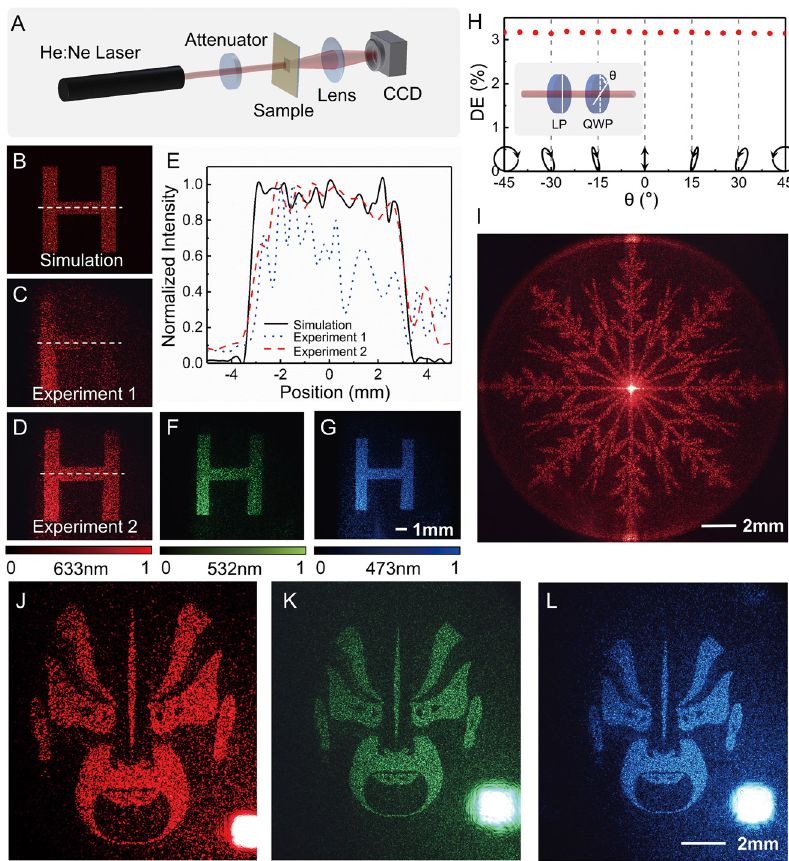
Figure 5: Comparison of holographic imaging quality and analysis of optical characteristics. (A) Scheme of homemade optical system for holographic image reconstruction. (B) Simulated reconstructed image of the calculated binary hologram. (C), (D) Optical images reconstructed from the fabricated holograms shown in Figure 4 C, D, respectively. A 633-nm laser was employed inmeasurement.Thedefinitionofthe “ H ” in (D) is superior to that in (C). (E) Normalized intensity profiles along the white dashed lines in (B) – (D). The black line (simulation) corresponds to the simulation result in (B). The blue dotted line (experiment 1) and the red dashed line (experiment 2) are plotted from (C) and (D), respectively. (F), (G) Optical images reconstructed from the hologram in Figure 4 D under irradiation by laserswith wavelengths of 532 and473 nm, respectively. (H) Measured differential efficiency of the hologram under different polarization states of the 633-nm laser by tuning the angle θ between the transmission axis of a linear polarizer (LP) and the fast axis of a quarter-wave plate (QWP). (I) – (L) Snowflake and Peking Opera mask images reconstructed from 600 × 600 px binary